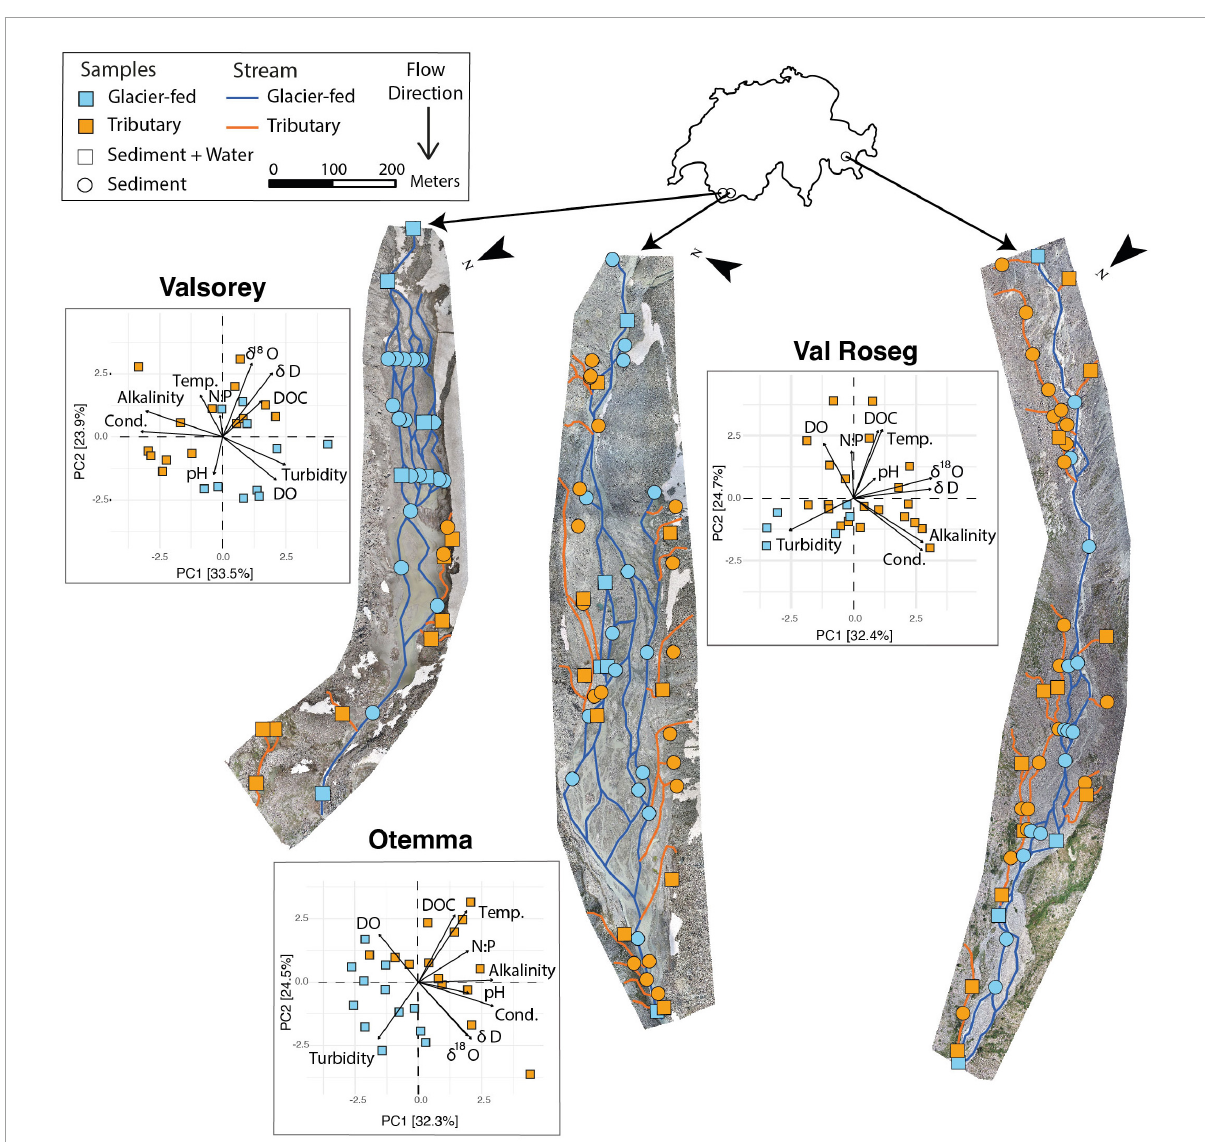
FIGURE1 Maps of sampling locations for Valsorey, Otemma, and Val Roseg floodplains with principal component analysis on water samples. Streams were digitized from orthomosaics, with orange and blue lines as TRIB and GFSs, respectively. Round-shaped points identified sites with exclusive sediment sampling, while square-shaped points identified sites with both water and sediment sampling, providing a total of 131 benthic sediment and 40 water sites. Principal Component Analysis for individual floodplains using the water chemistry data collected for both seasons, where different colors represent the stream types (blue: GFS, orange: TRIB). The following acronyms were used to maximize space in the figure: Temp., Temperature; Cond., Conductivity. There is a separation between the GFS and TRIB samples mainly driven by temperature and